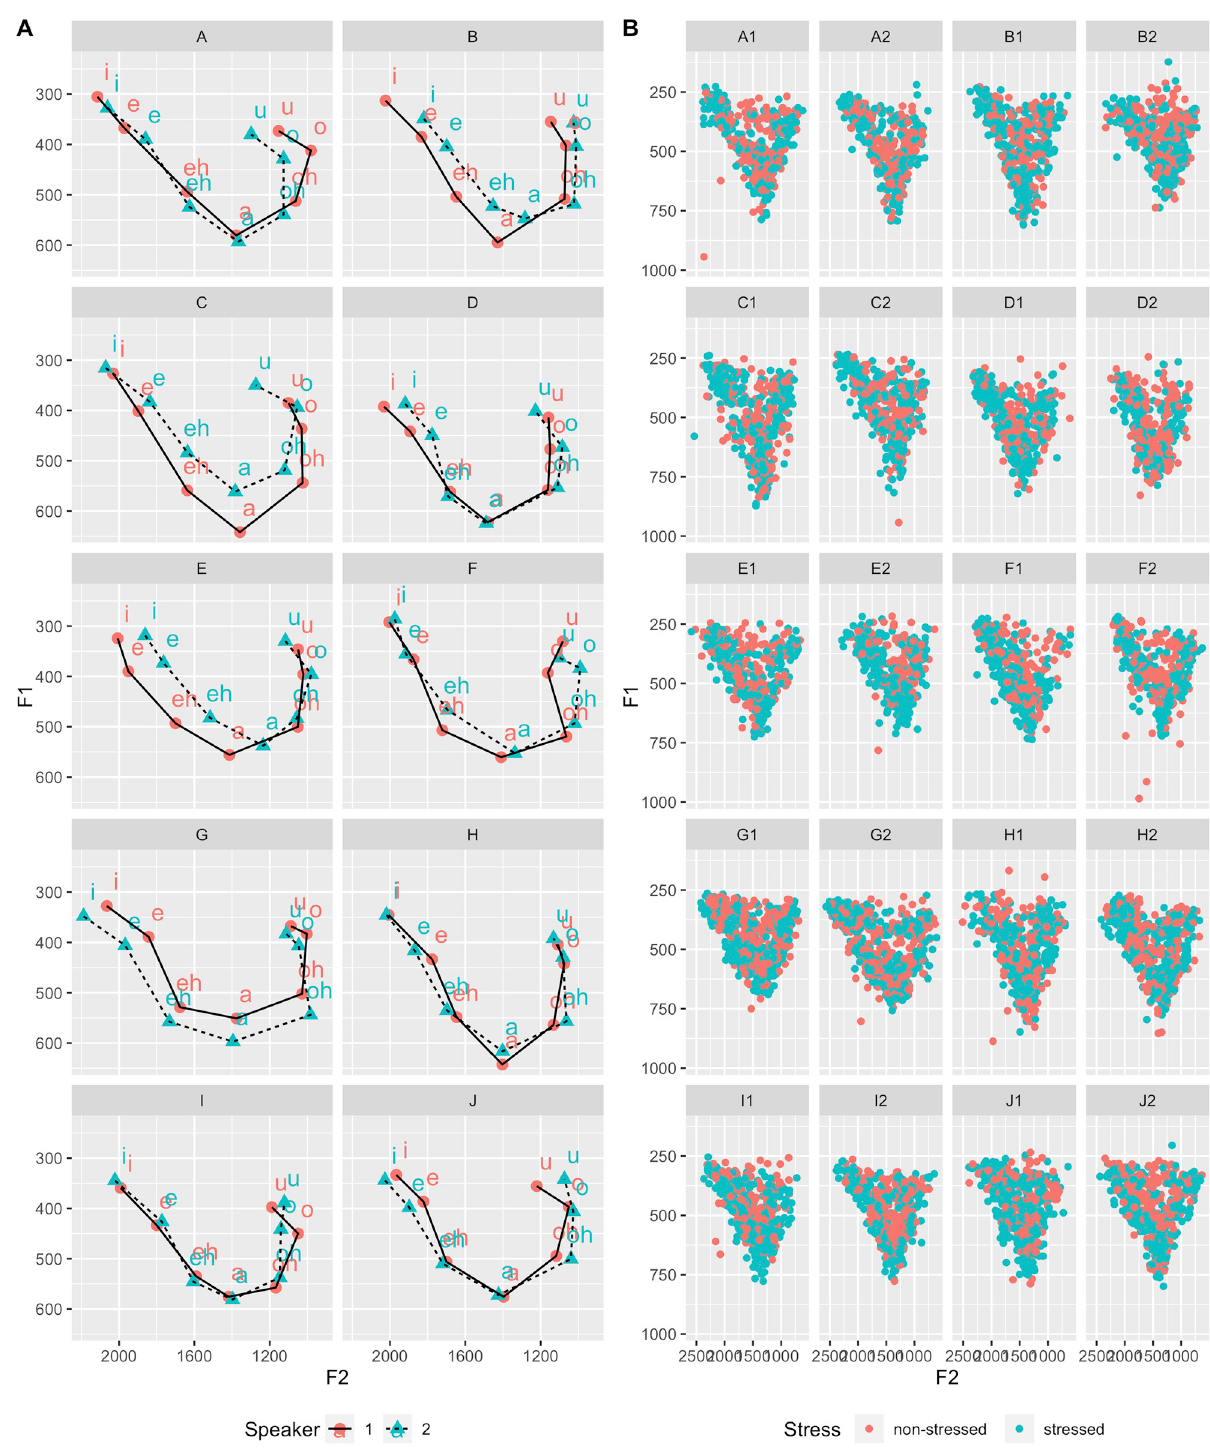
Fig 1. Two-dimensional vocalic space comparisons between identical twin pairs (A) and stressed and unstressed vowel data points by speaker (B).